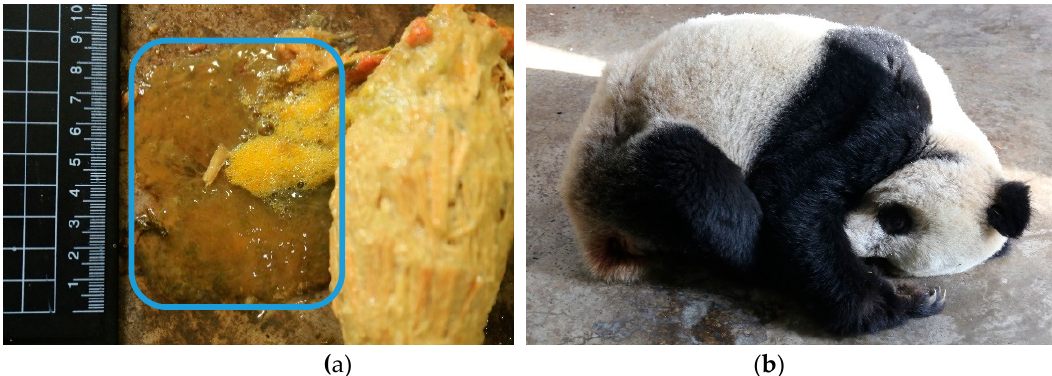
Figure 1. The mucus stool ( a ) and the uncomfortable panda ( b ) that recently finished mucus excretion (photo by Rongping Wei)